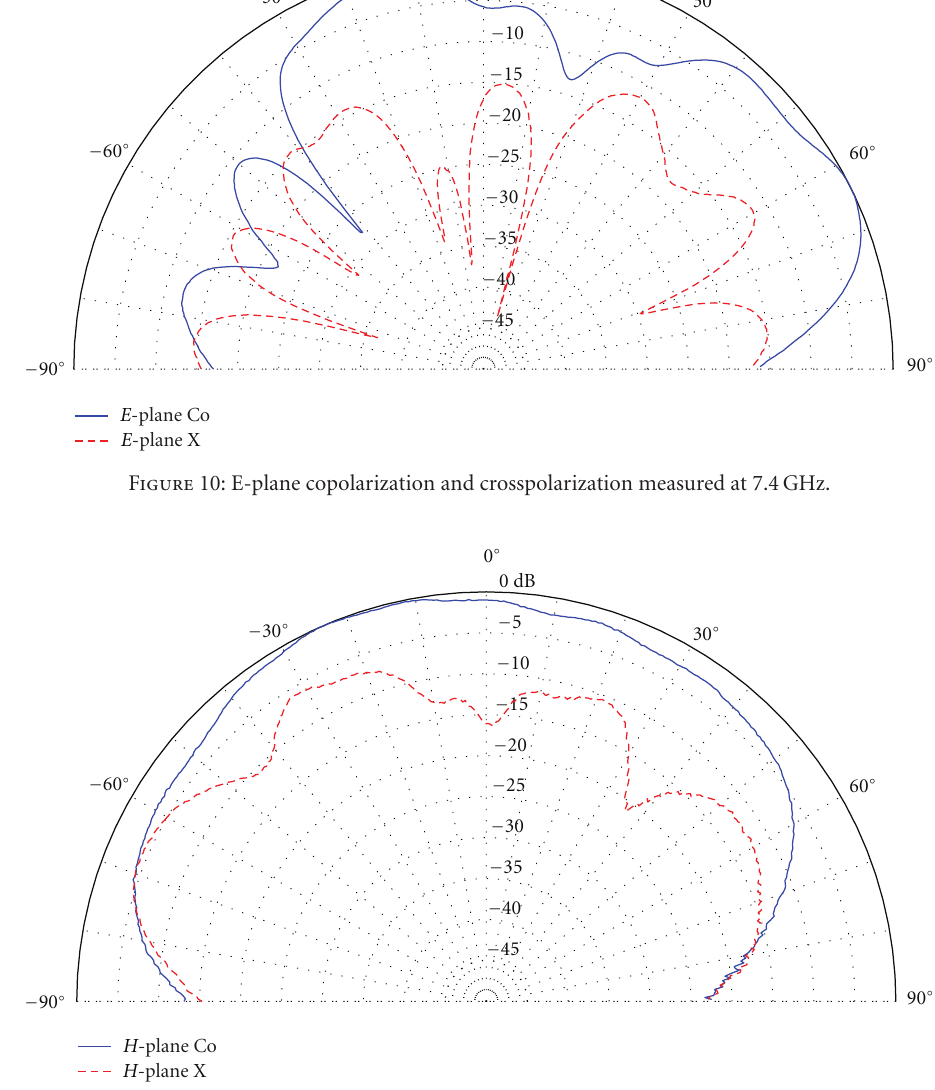
Figure 11: H-plane copolarization and crosspolarization measured at